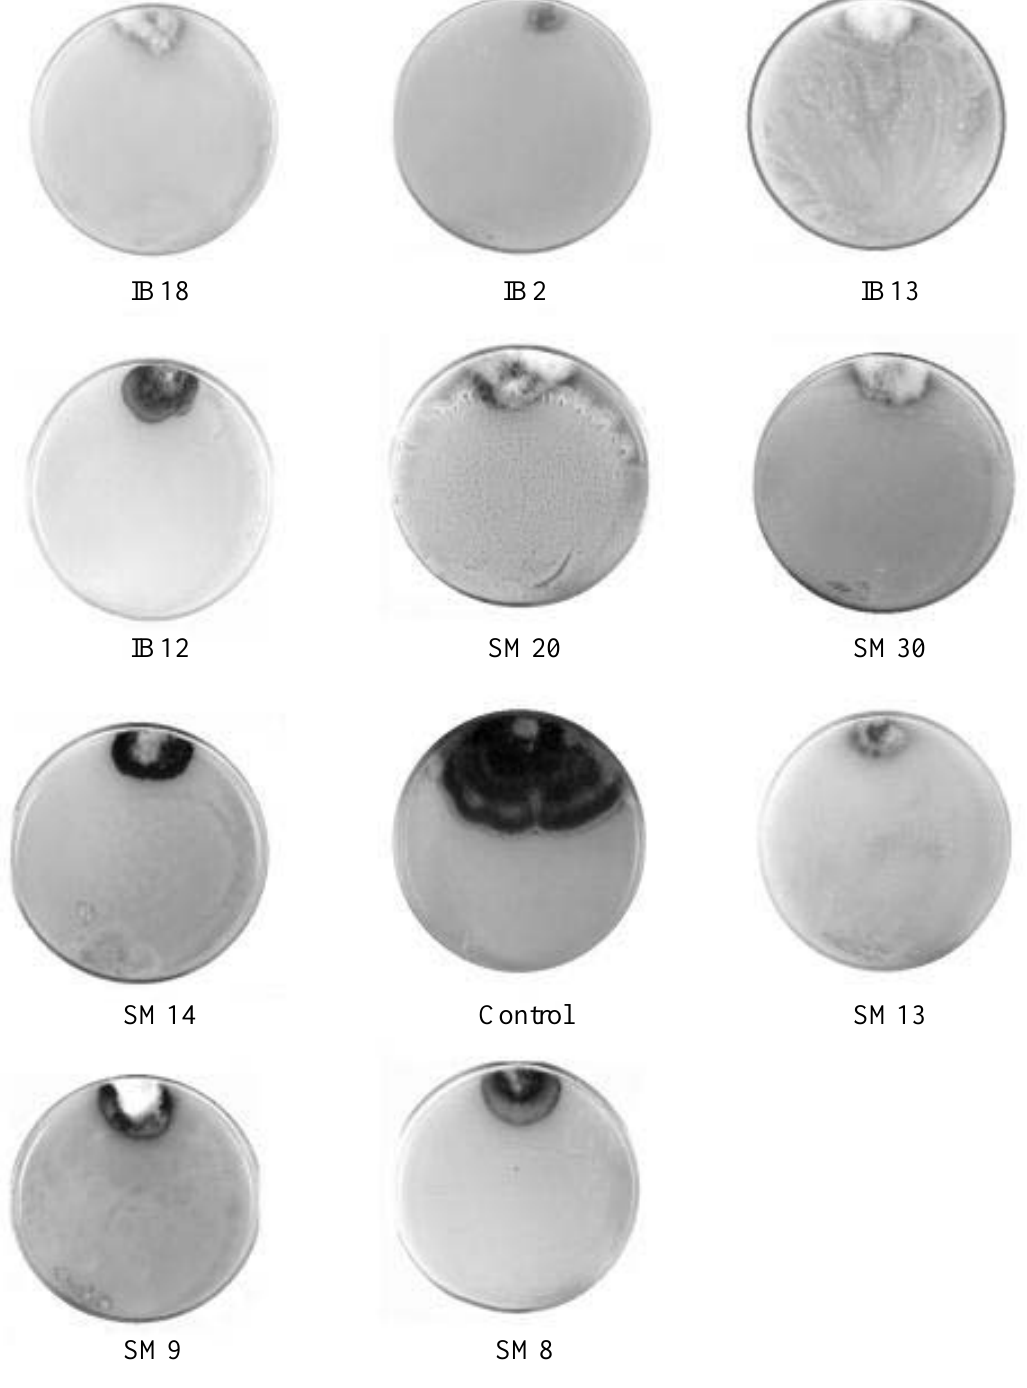
Fig. 1. An example of the antagonistic effect of some of the bacterial isolates used in this study against the fungal pathogens tested. Top of Petri plate: A. tenuis ; bottom, different bacterial strains isolated from eggplant (SM) or sweet potato